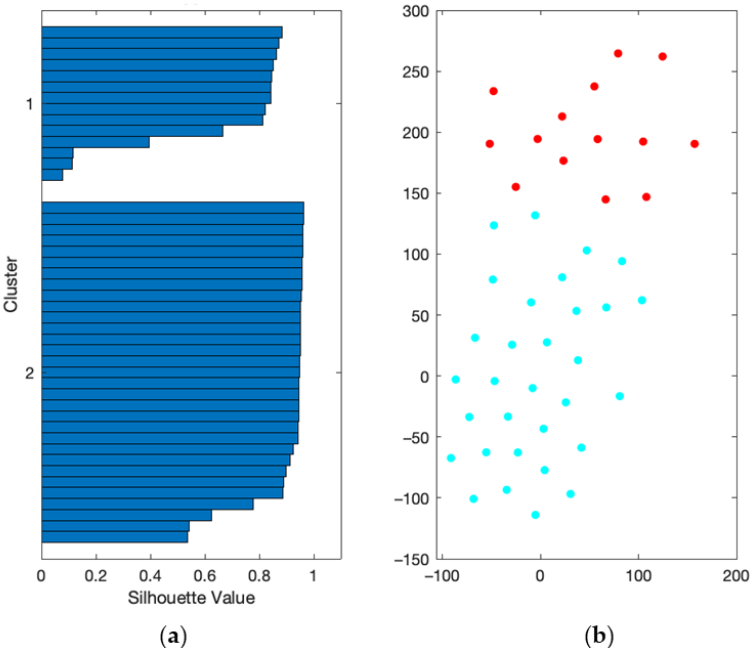
Figure 1. Unsupervised classification performance. ( a ) Silhouette values, a measure of the individual’s parenthood within the underlying cluster, were plotted on the y-axis for high (cluster 1) and low (cluster 2) T cell responders, respectively. ( b ) t-SNE graphical model of k-spectral clustering analysis with two clusters. Each dot represents an individual projected in a two-dimensional space. High T cell responders are represented by a red dot, and low T cell responders by a blue dot.